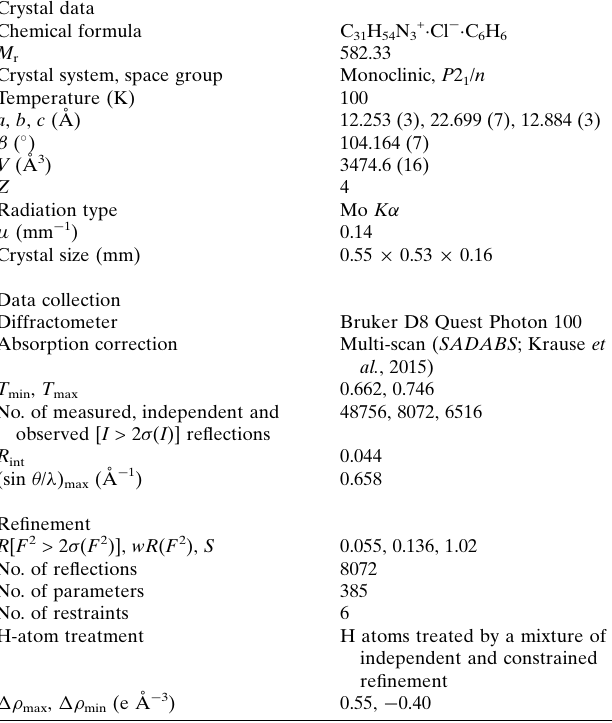
Table 2 Experimental details. Crystal data Chemical formula